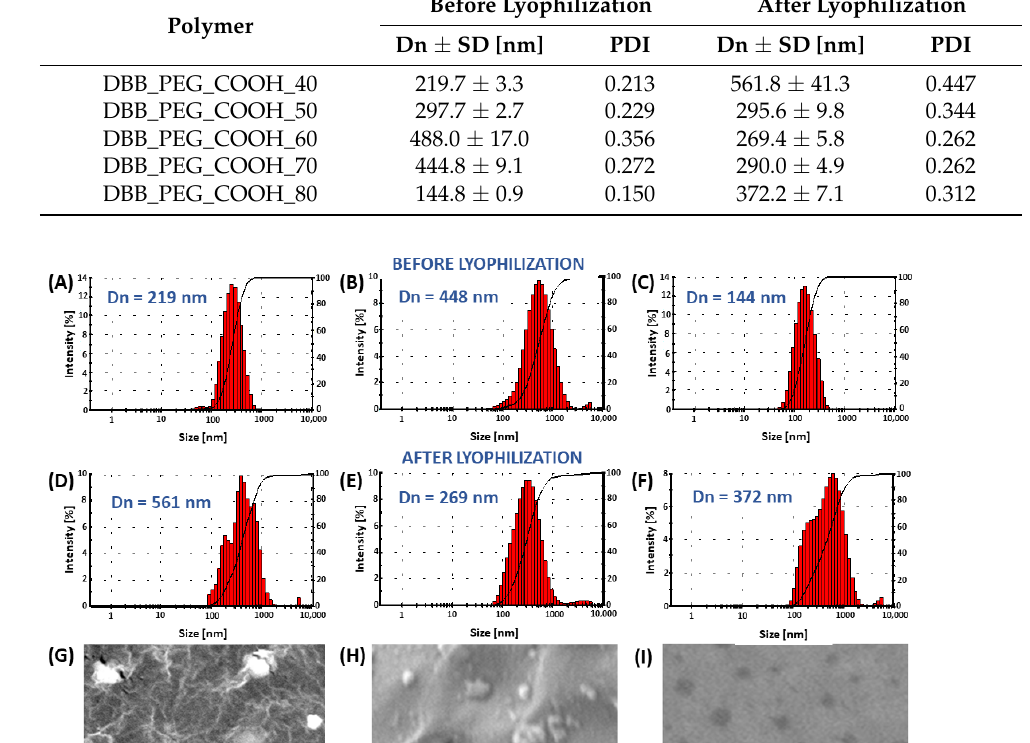
Table 3. The sizes of polyDBB_PEG_COOH micelles.